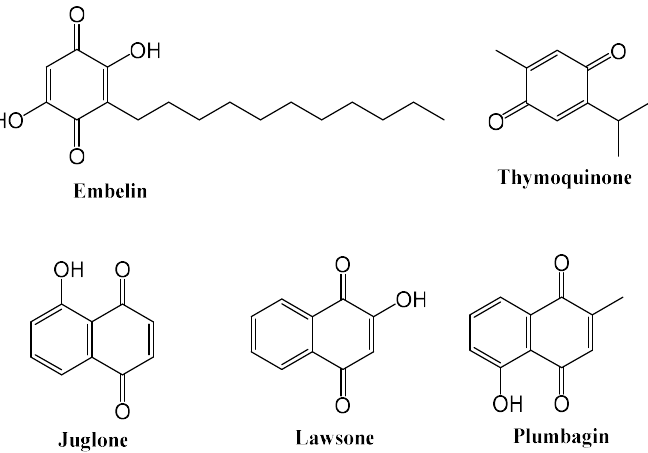
Figure 1. Quinone-based plant products with anti-colorectal cancer properties .